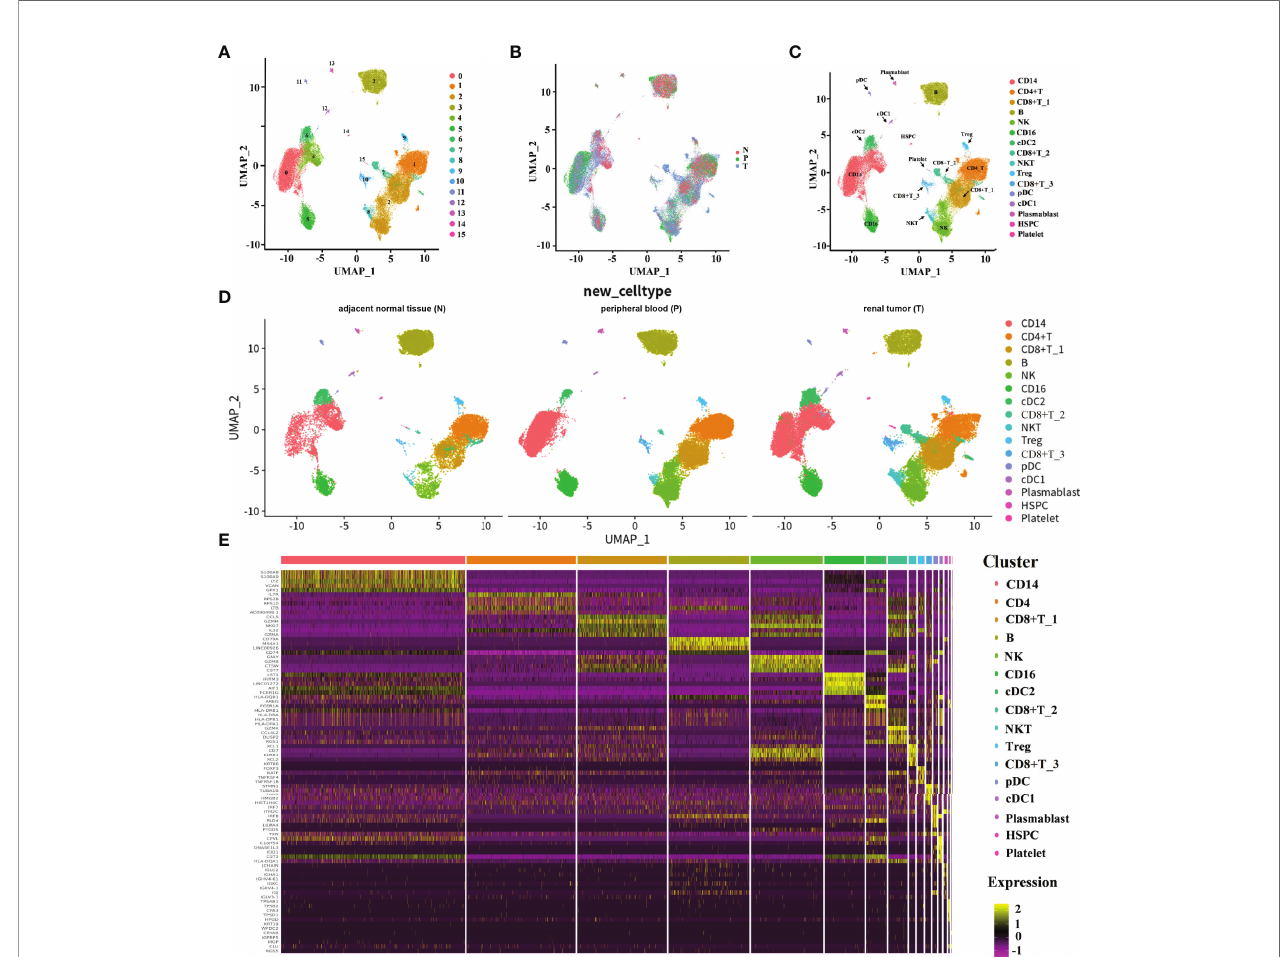
FIGURE 1 | The immune landscape of patients with ccRCC at single-cell resolution. (A – D) UMAP embedding of transcriptional pro fi les from all patients and samples. Each dot represents a single cell, and colors represent clusters denoted by inferred cell type or tissue type. “ N ” is an abbreviation for adjacent normal tissue, “ P ” is for peripheral blood, and “ T ” is abbreviated for tumor tissue. (E) Heatmap of top 5 normalized expressions of markers in each cell type. Each row indicated marker genes, and columns represented cells. Yellow indicates high log-normalized expression; purple indicates low log-normalized